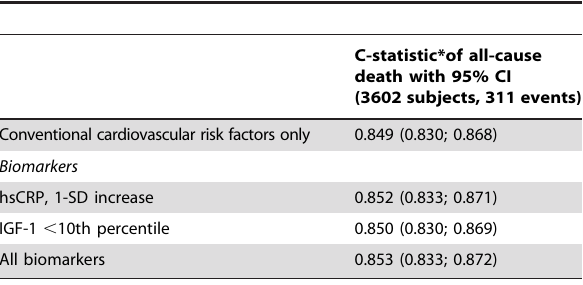
Table 7. Improvement of prediction of all-cause death by biomarkers.